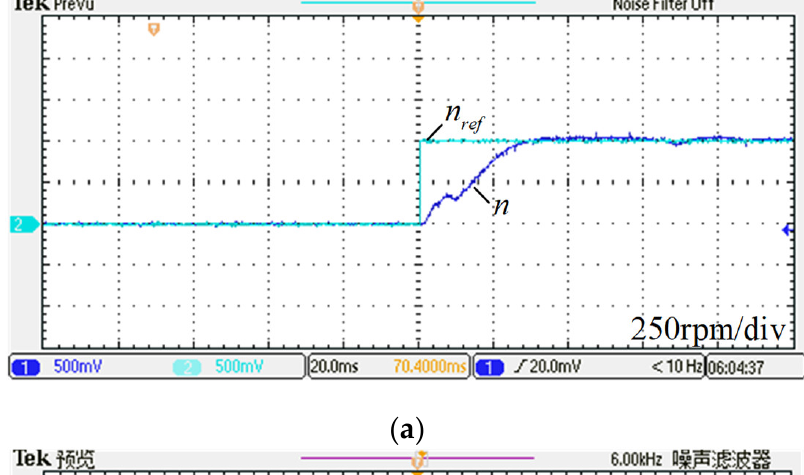
11 of 14 Figure 5. Continuous speed transient state: Channel 1: actual speed, Channel 2: reference speed (250 rpm/div), Horizontal: Time (2 s/div).